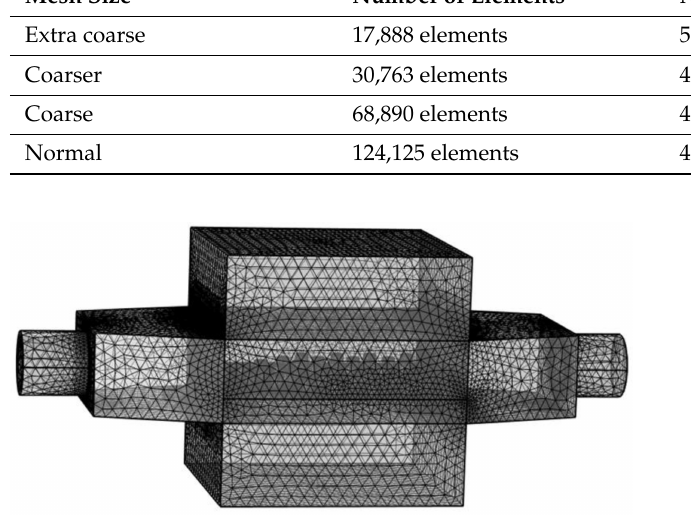
Figure 2. Finite element mesh.